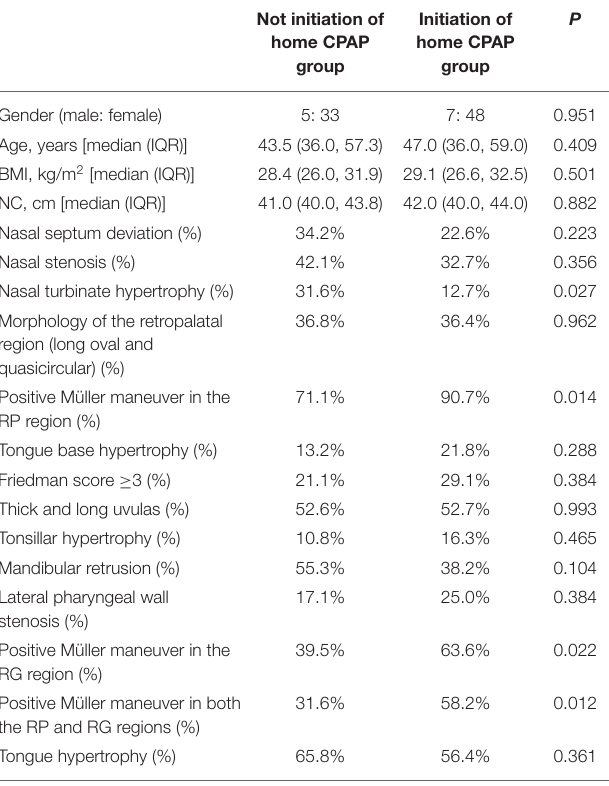
TABLE 3 | Effect of upper airway (UA) characteristics on the initiation of home continuous positive airway pressure (CPAP) therapy.